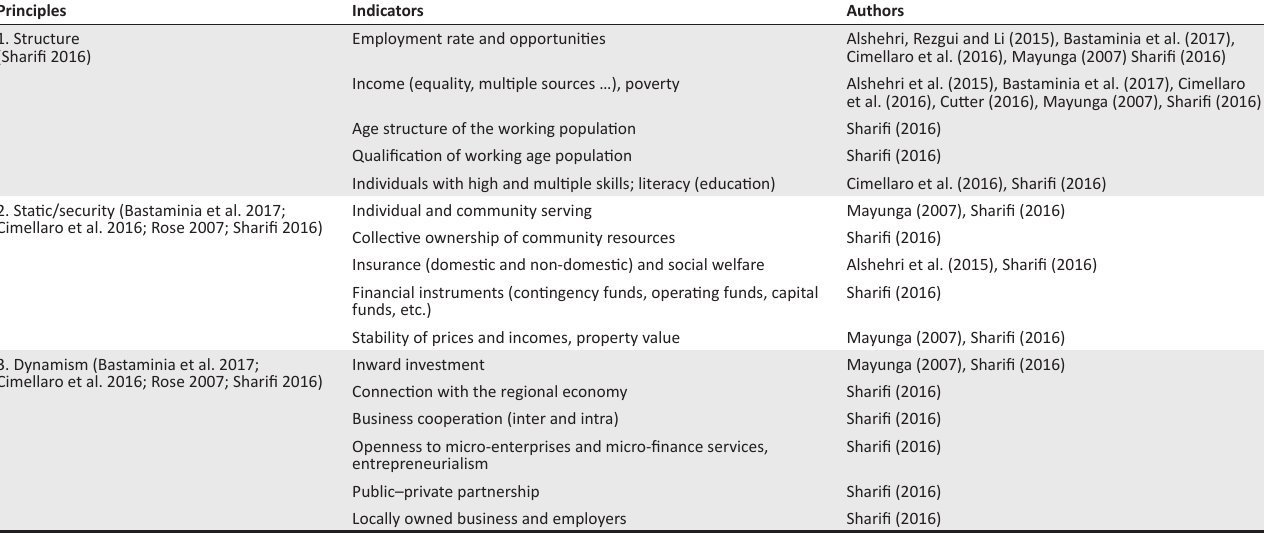
TABLE 1: Common factors used in assessing the economic resilience. Principles